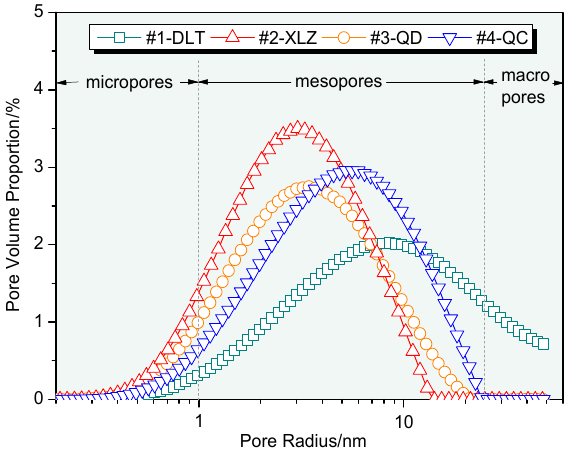
Figure 4. The pore size distributions measured by